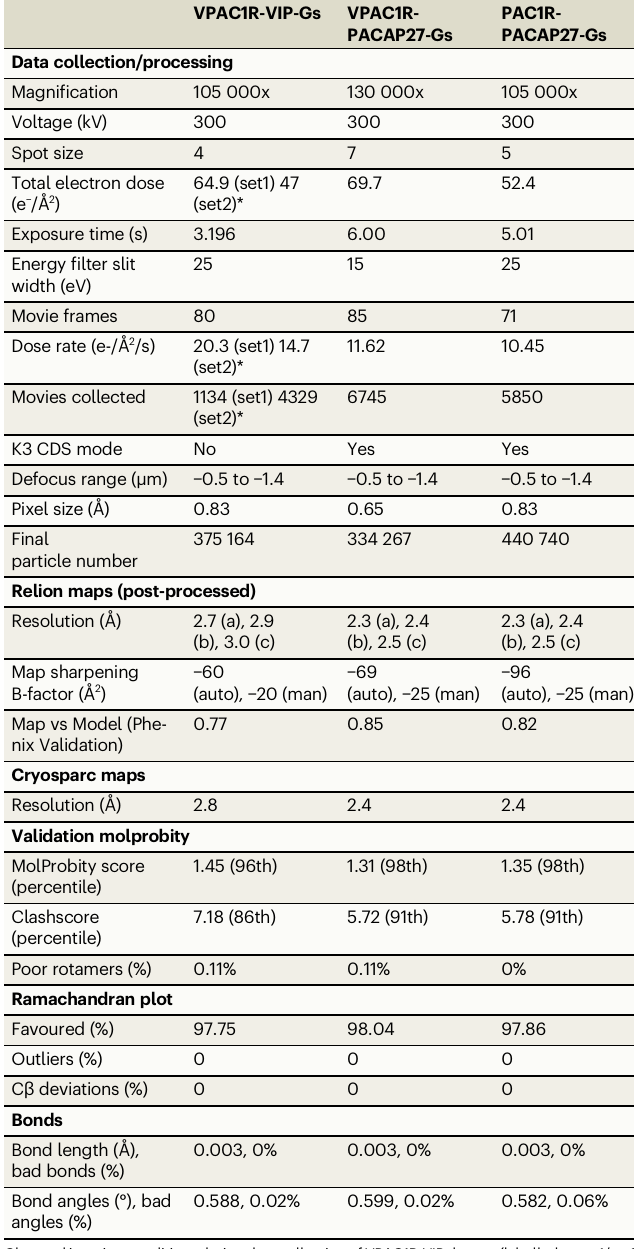
Table 1 | Map and model information for VPAC1R-PACAP27, VPAC1R-VIP and PAC1R-PACAP27